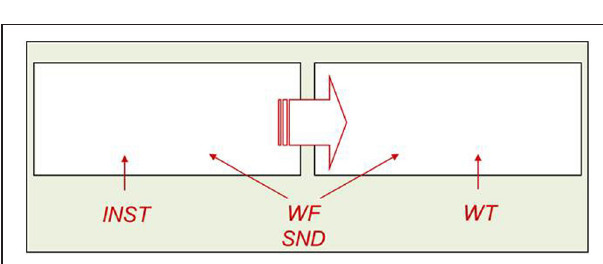
FIGURE 4 | A cognitive chronometric architecture to account for the INST × WF, INST × SND, WF × WT, and SND × WT over-additive interactions, and INST + WT